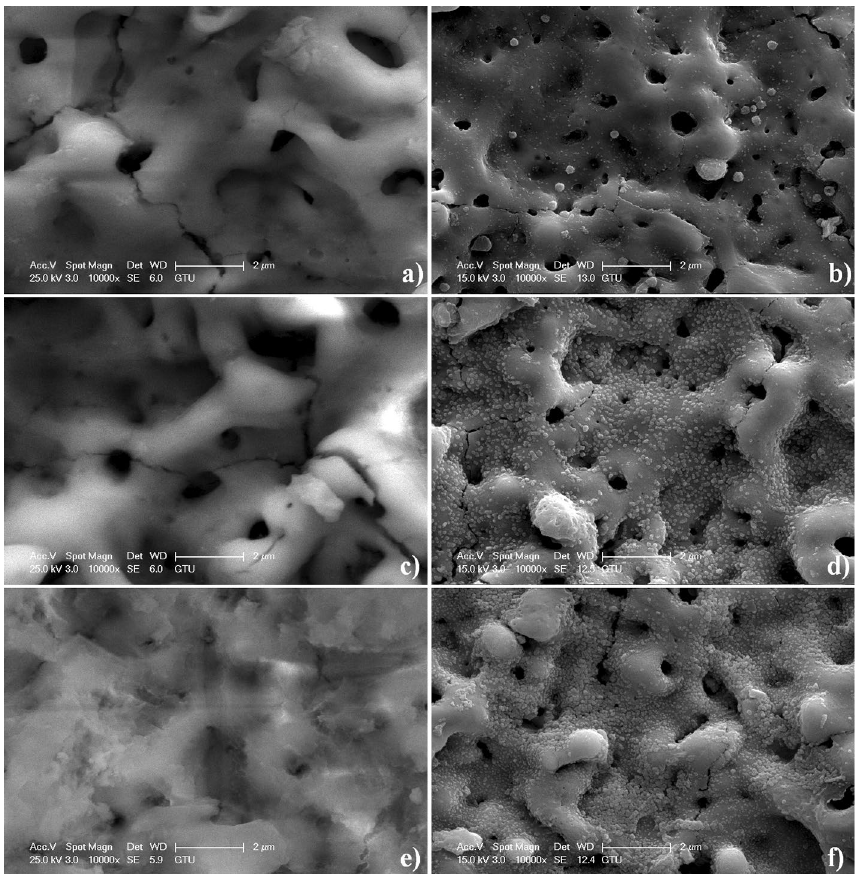
Figure 5. Surface topography of the MAO and AgNPs-doped MAO surfaces taken at high magnifications: ( a ) MAO-15, ( b ) MAO-15-Ag, ( c ) MAO-30, ( d ) MAO-30-Ag, ( e ) MAO-45 and ( d )